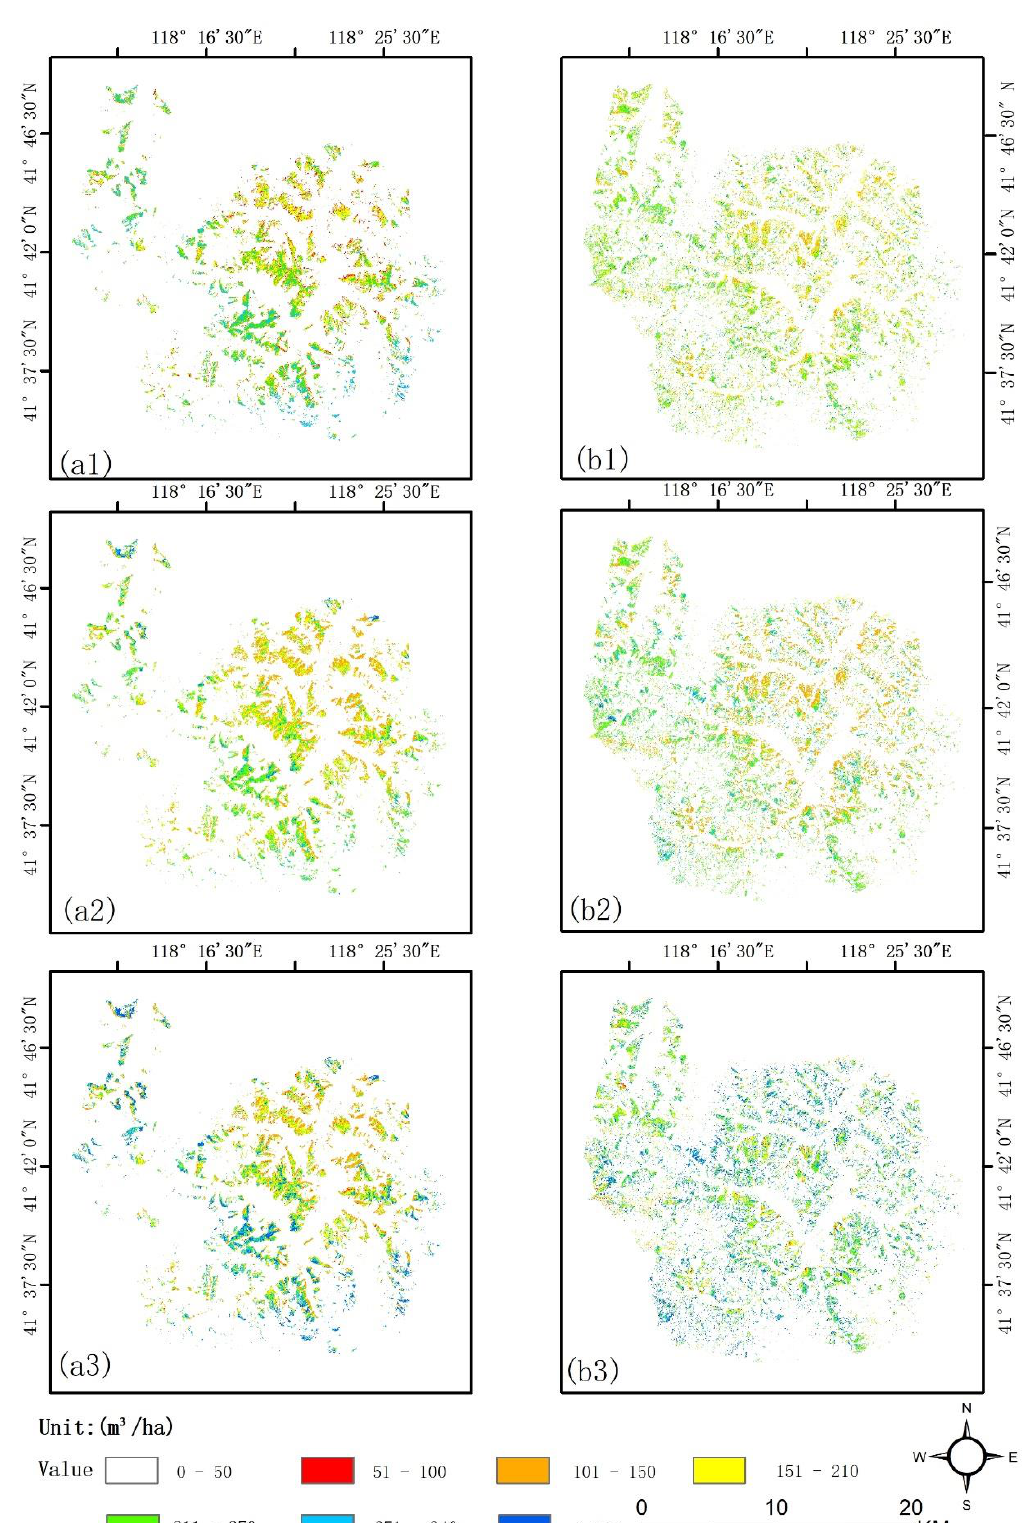
Figure 5. The GSV maps of ( a1–a3 ) Chinese pine and ( b1–b3 ) larch plantations in the study area estimated based on the fusion image Red_Landsat using the variables selected by SRA, RF, and DC-FSCK method, respectively. Each map corresponds to the best estimation model with the smallest RMSEr value for each data scenario in Table 6.